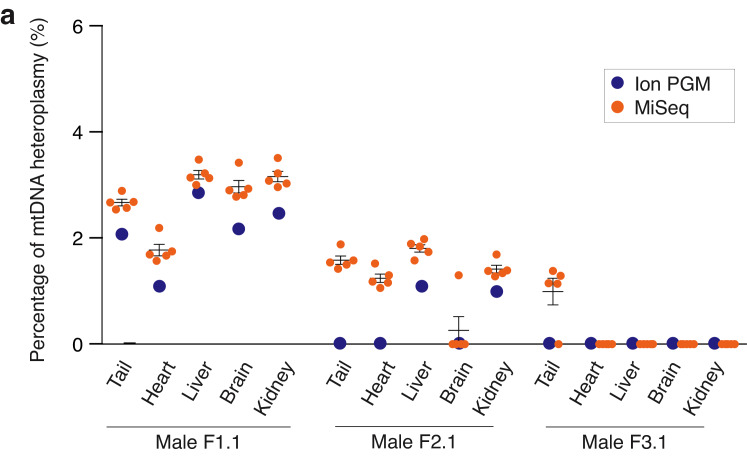
Validation of established sequencing protocol for mtDNA carryover analysis using two sequencing platforms.Allele frequencies at positions m.2798, m.2814, m.3194, m.3260 and m.3932 in five adult mouse tissues from NZB-sp/B6-cyt MST mice measured with MiSeq (orange) and SNP m.3932 in Ion PGM sequencer (blue). Non detectable values are plotted as 0. No statistical differences were found between quantifications of both methods (Student’s t p>0.05). See also.